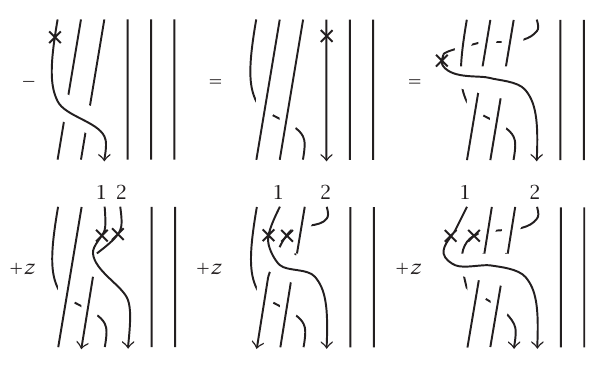
Figure 6.3 . A refinement of 2¯ K